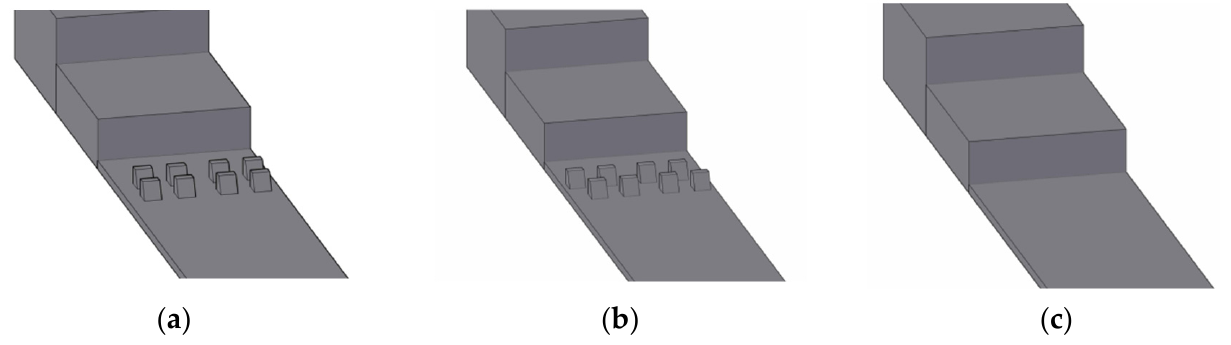
Figure 3. Mesh sensitivity analysis.